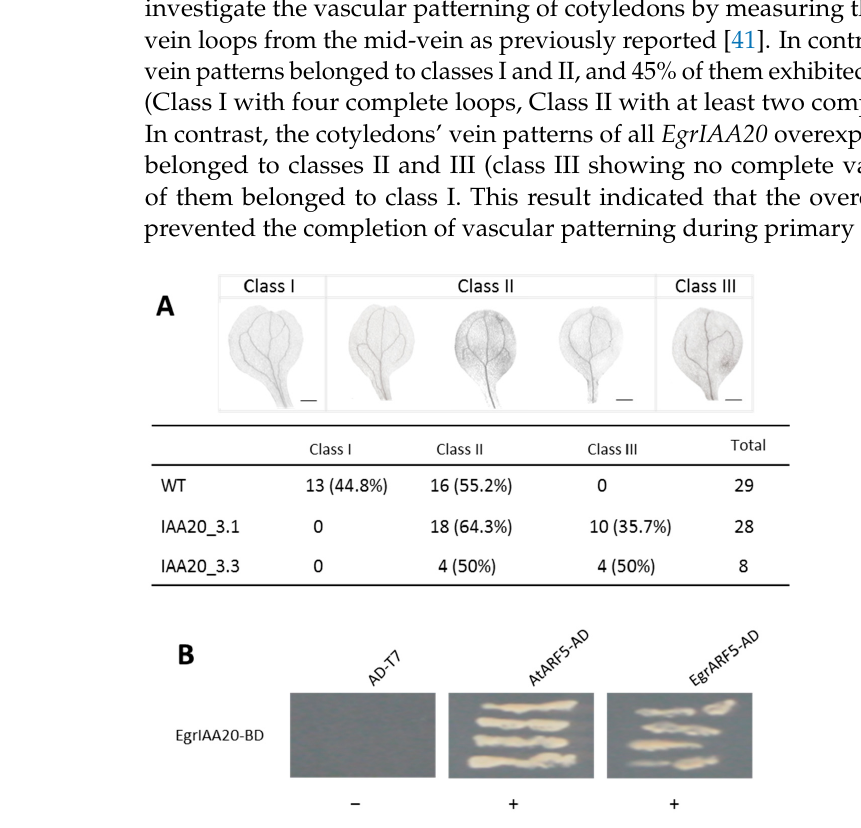
Table 1. Chemical composition of wild type and EgrIAA20_OE transgenic Arabidopsis hypocotyls by Py-GC/MS analysis (n > 12). Genotype Carbohydrate